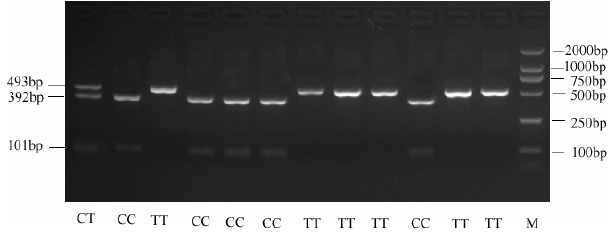
Figure 1. PCR-RFLP band pattern on a 3% non-denaturing poly- acrylamide gel. The TT (also named C 1 C 1 T 2 T 2 ) genotype has one slow-running band; the CC (also named T 1 T 1 C 2 C 2 ) genotype has one fast-running band; and the CT (also named C 1 T 1 C 2 T 2 ) geno- type has two bands, one of which is slow-running and the other